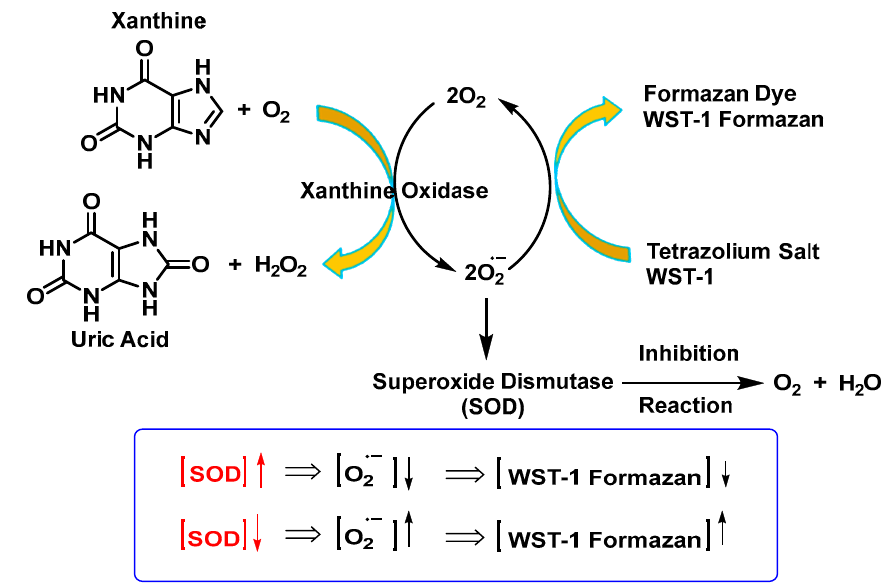
Figure 41. SOD inhibition assay mechanism.